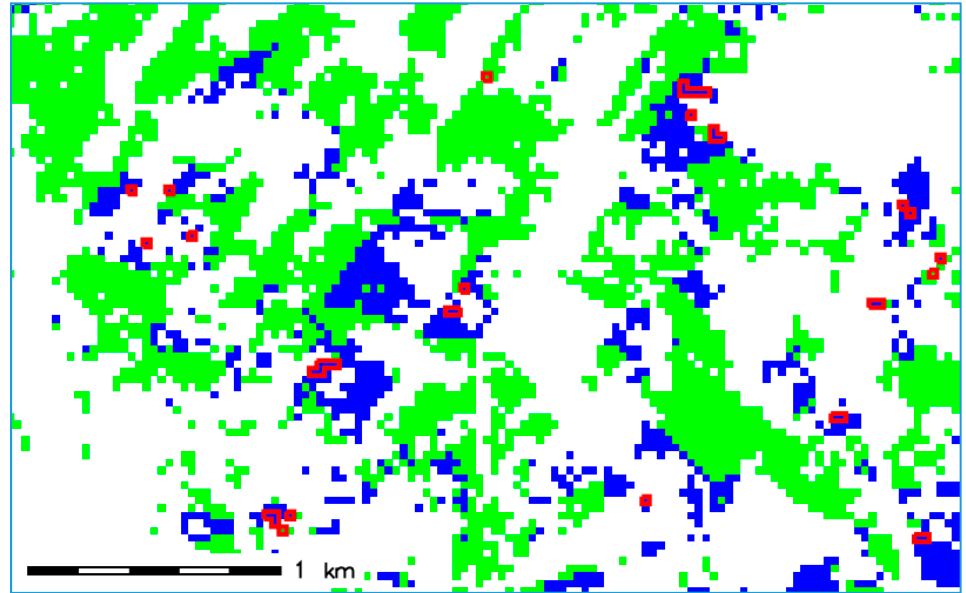
Figure 3. Boxplot of phi coefficients ( 𝜙 ) of the top FDMs generated by MLAs. Box plots show me- dian plus upper and lower quartiles of the phi coefficient for the period 2003–2012. Minimum and maximum values are indicated by the upper and lower whiskers (1.5 × interquartile range). Circles are outliers. The MLA codes are given in Table 3.